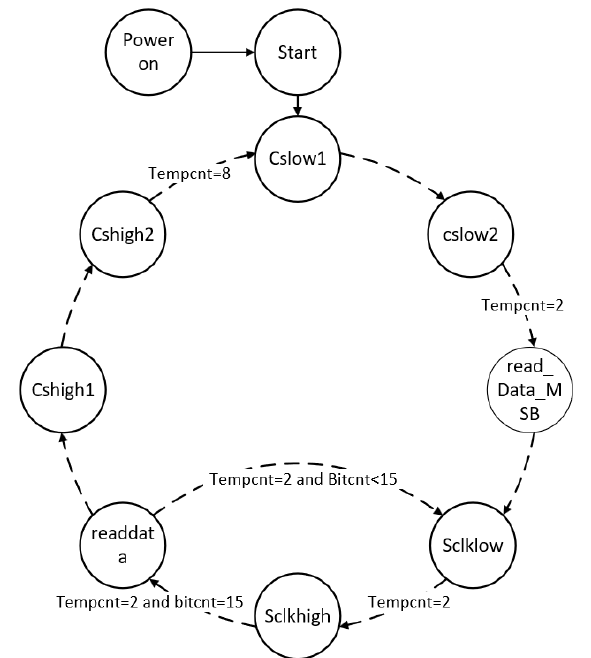
Figure 18. Timing diagram of the ADC.